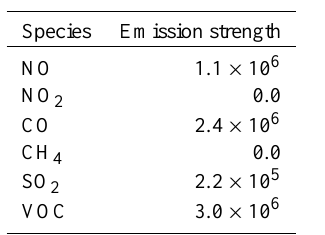
Table 3. Emission strength as volume production rate incm − 3 s − 1 for scenario PLUME. For scenario URBAN, the emission strength of NO of scenario PLUME has to be multiplied by 5, while the emission strengths of all other species remains